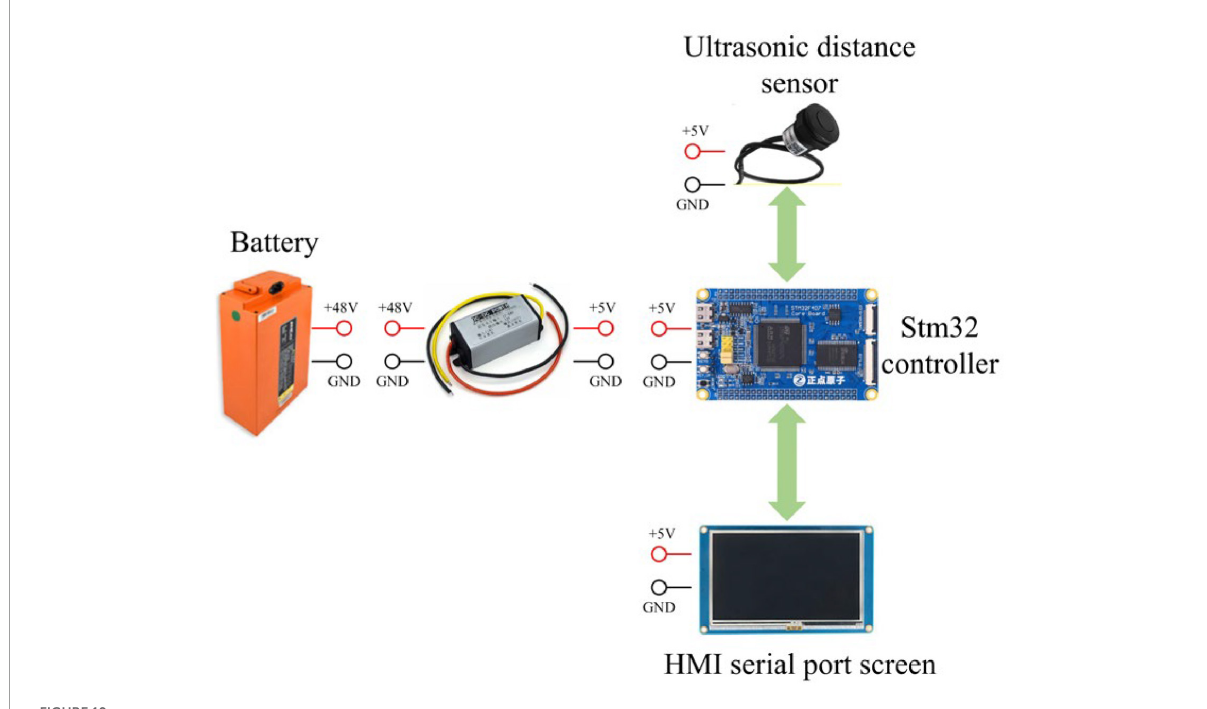
FIGURE19 Hardware system composition of an arc array edge navigation sensor module.